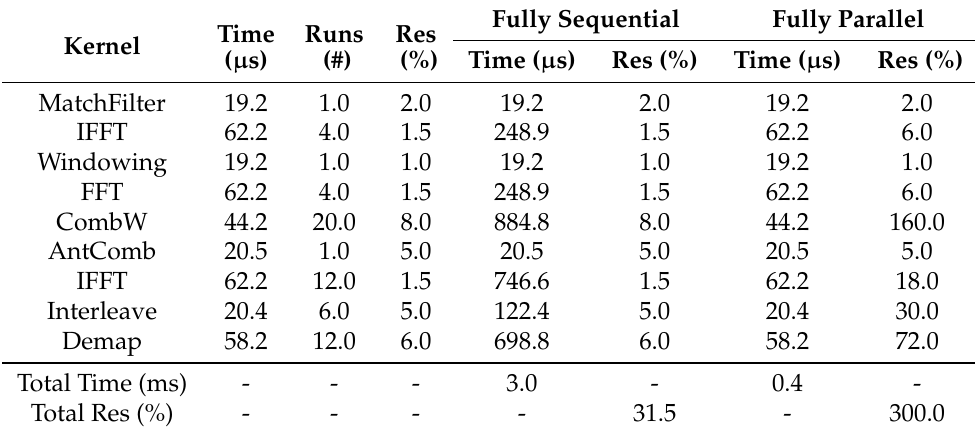
Table 4. The result of running uplink application of PHY-Bench on XCZU3EG-SBVA484 FPGA for fully sequential and fully parallel strategies when LAY = 2, ANT = 2, SC = 1200, SYM = 6, and MOD =